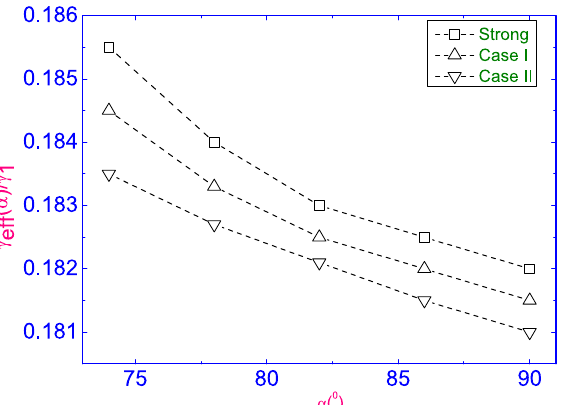
Figure 8. Plot of the dimensionless ERV coefficient γ eff ( α , W ) / γ 1 vs. the angle α for a number of values of the anchoring strength W